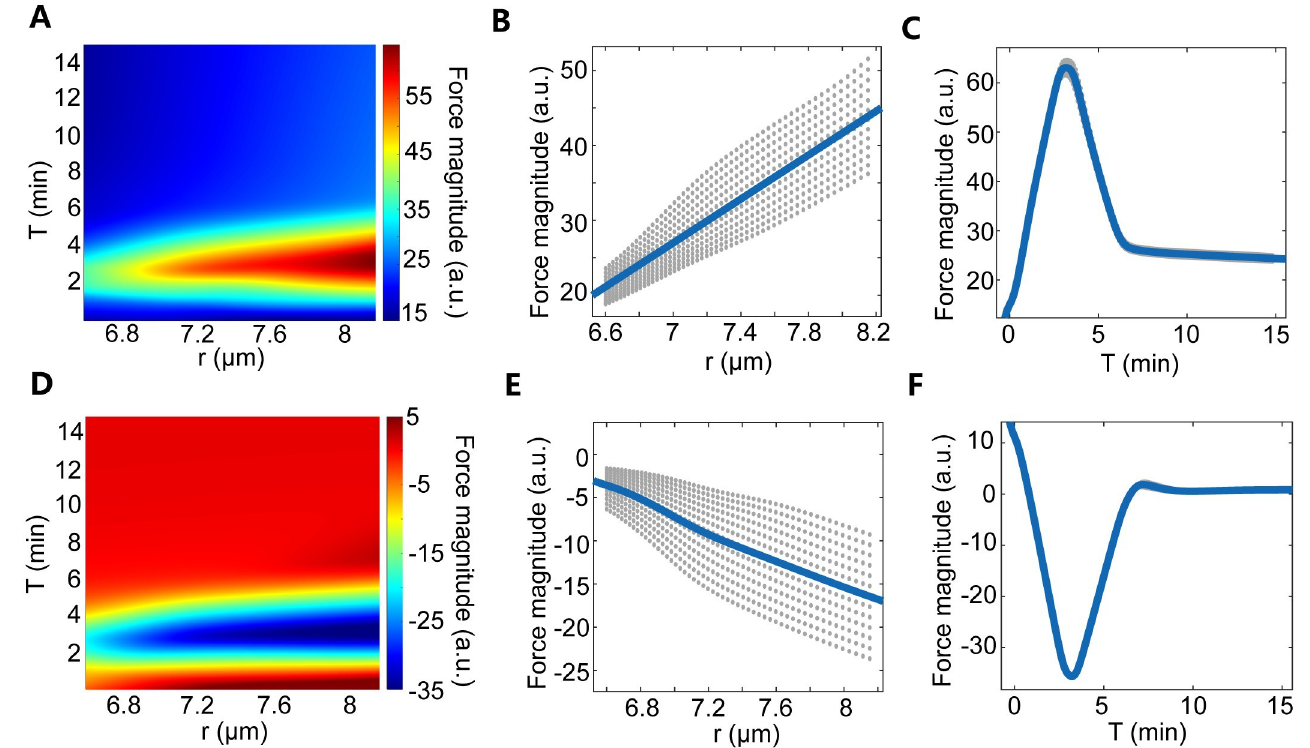
Fig 3. Force field functions learned from 1D data via the MLFNN model. (A-C) The DNN learning results based on the F a assumption. The data from M phase 13 to interphase 14 in one embryo (3078 data points in total) is used while training the DNN. (A) A representative heat map of the function F ( T , r ).Here F is the magnitude of the internuclear force ( F learned ), T is the nuclear age after the onset of anaphase, and r is the internuclear distance. Note that, r ¼ i ; j here s is the Voronoi area of each nucleus. (B) F has a positive correlation with r as T = 4.4–5.6 min. (C) F has a pulsatile relationship with T as r = 7.9–8.2 μ m. (D-F) The DNN learning results based on the F r assumption as in A-C.